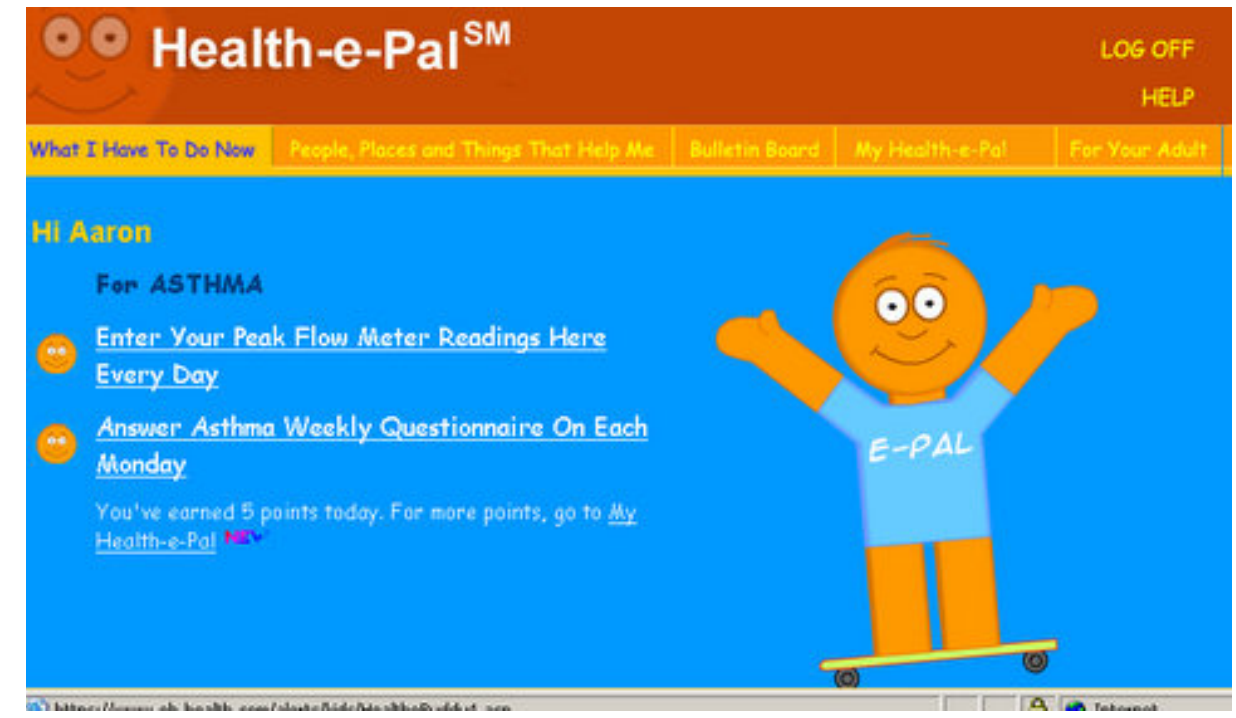
Figure 1. Pediatric interface of Health-e-Pal ALERTS